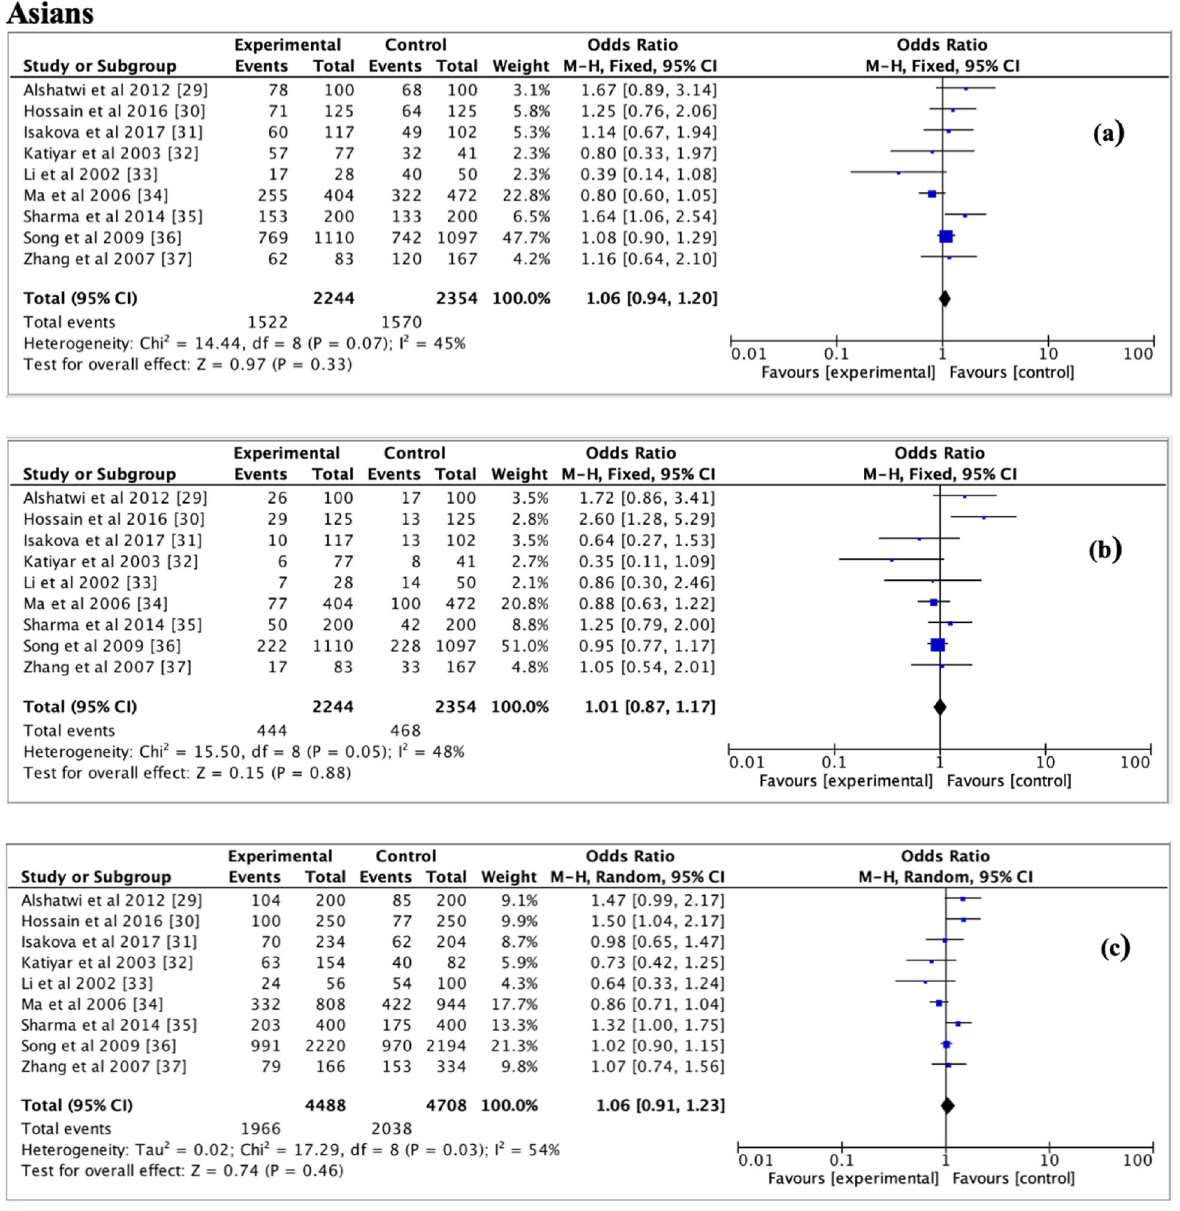
Fig. 6 Forest plots of the association between breast cancer and TP53 p.Arg72Pro polymorphism for the a dominant model, b recessive model and c additive model in Asians. The black diamond denotes the pooled OR; blue squares indicate the OR in each study with square sizes inversely proportional to the standard error of the OR; and horizontal lines represent the 95%